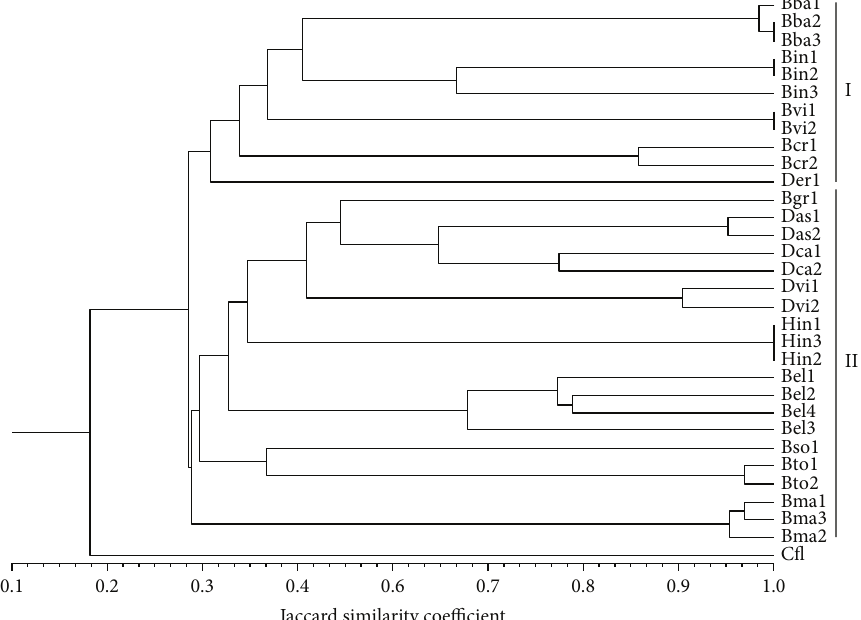
Figure 2: Dendrogram obtained by UPGMA clustering analysis of PCR-RFLP marker data, of 31 accessions corresponding to 14 wild relatives of brassicas and Cardamine flexuosa as outgroup. See Table 1 for code of species and accessions.